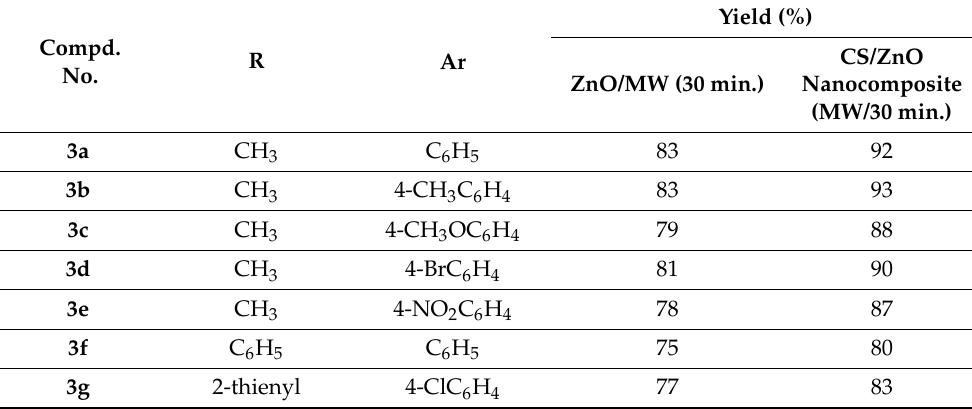
Table 3. Comparative yield (percentage) of different 3a – g thiazoles using ZnO nanoparticles and chitosan ZnO nanocomposite as innovative core enhancers.